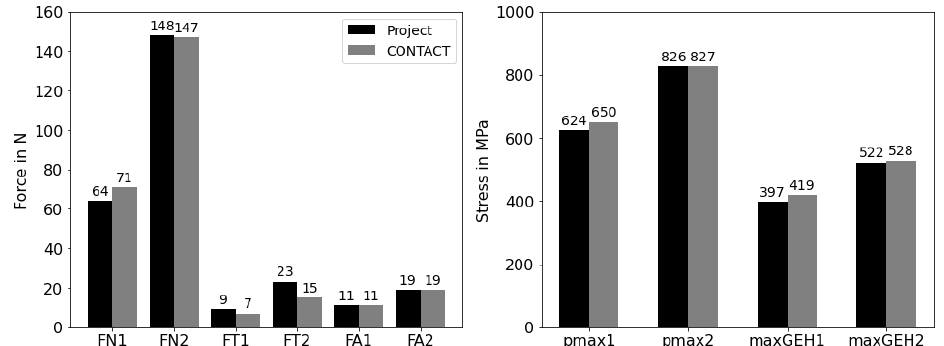
Figure 8. Comparison of force values (left) and stress values (right), Steel/steel, F rad = 200 N, F ax = 30 N, µ = 0.3, driven rolling.